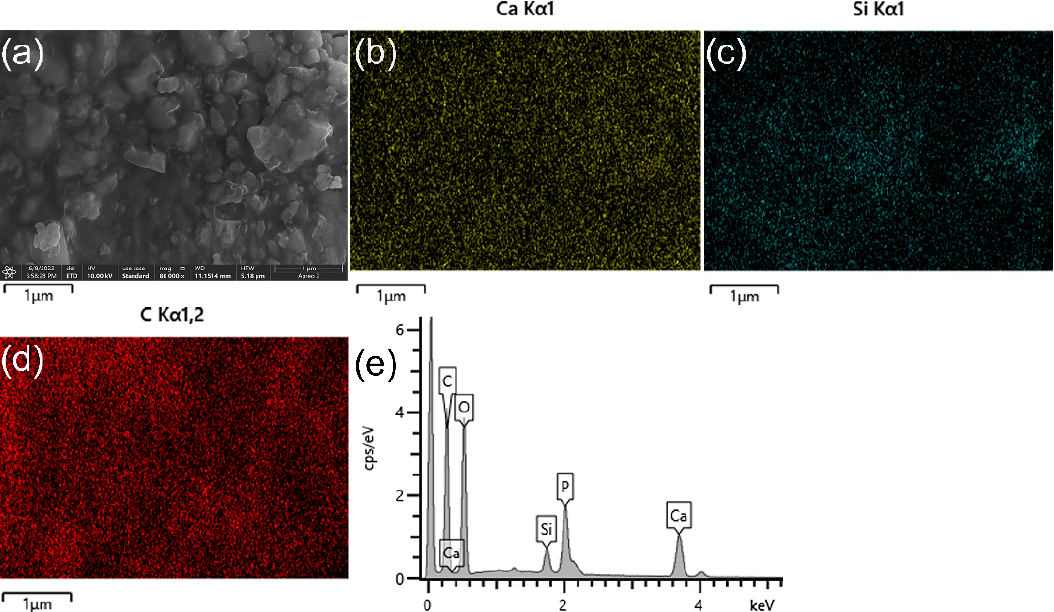
Figure 4. Energy spectrum of the hybrid polymer–ceramic material fracture surfaces of 20 wt.% BAG sintered at 1000 °C: ( a ) secondary electron image of hybrid polymer–ceramic material; ( b – d ) the distribution diagrams of Ca, Si, and C in ( a ), respectively; ( e ) the energy spectrum of ( a ).